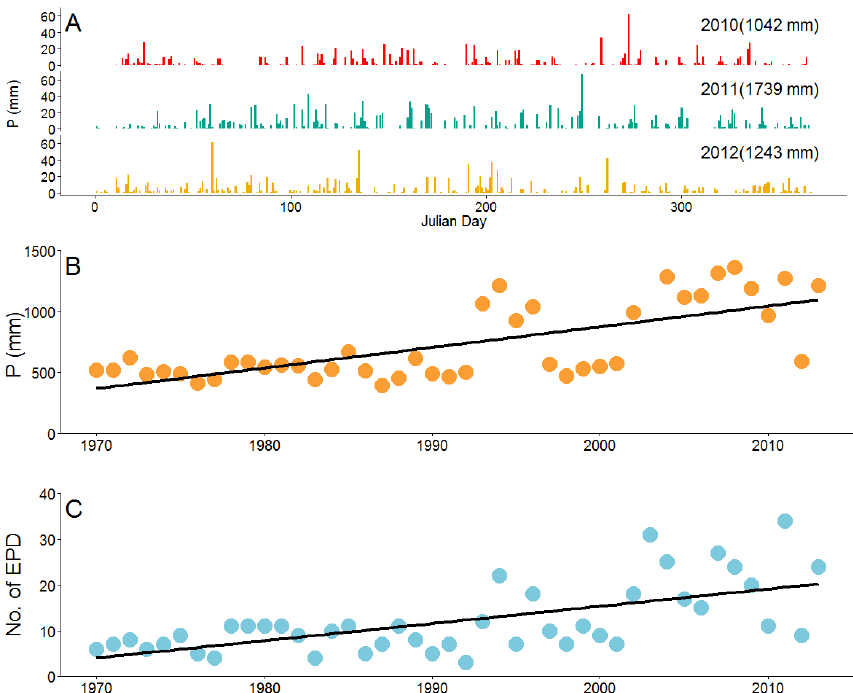
Figure 6. (a) Hyetographs for 2010, 2011, and 2012 from the Bearden Knob weather station located within the Weimer Run watershed (BDKW2 MesoWest; University of Utah). Precipitation totals by year are indicated within each graph and are in millimeters per year. (b) Precipitation for the years 1970–2013 (mmyr − 1 ) from NCDC station Canaan Valley, WV (461393). Linear regression shows that mean annual precipitation is increasing by 17.88mmyr − 1 ( r = 0.697; F 1 , 42 = 39.74; R 2 = 0.474; p = <0.001). The year-to-year variance in pre- cipitation is also increasing (BP = 8.58; p = 0.003). (c) Number of extreme precipitation days (EPD) per year (defined as days on which total precipitation exceeded 25.4mm per day). The number of EPDs are increasing by 0.38 days per year ( R = 0.637; F 1 , 42 = 28.69; r 2 = 0.392; p = <0.001). The variance is also increasing (BP = 11.12; p = <0.001).